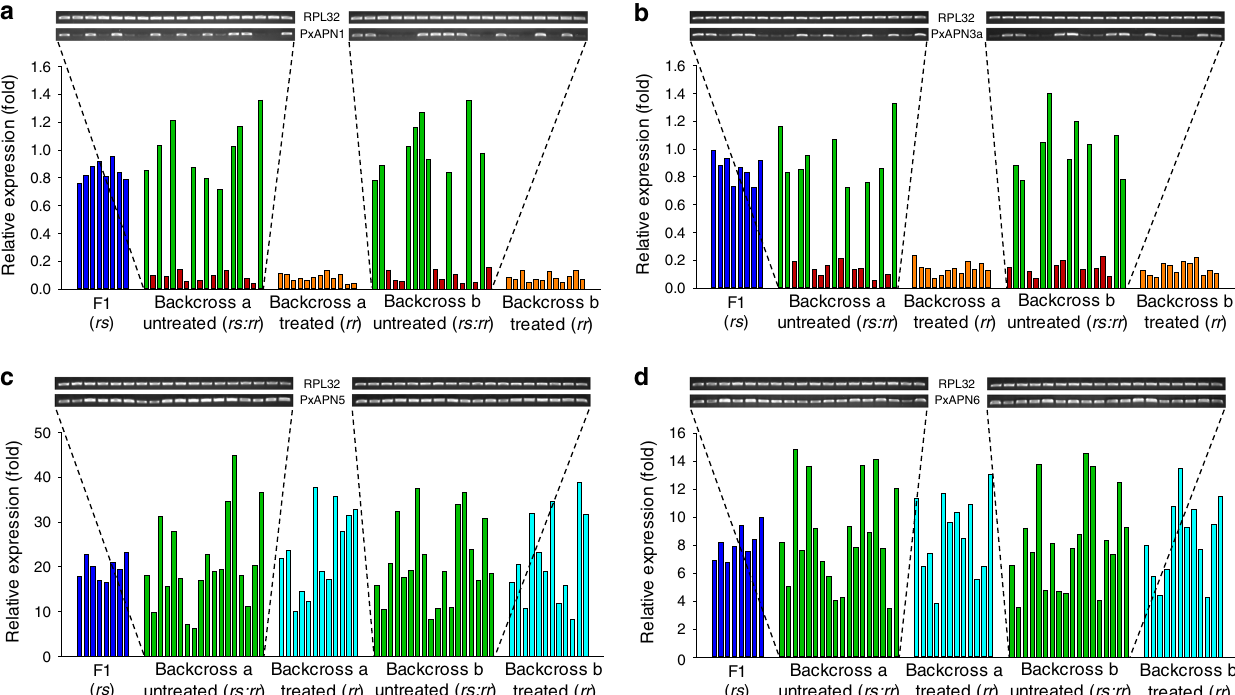
Fig. 3 Linkage of Cry1Ac resistance phenotype to reduced PxAPN1 and PxAPN3a expression. Expression levels for the F1, Cry1Ac-selected and non- selected backcross families are relative to levels in the susceptible DBM1Ac-S strain. Corresponding intensity of ampli fi ed transcript bands for the PxAPN1 ( a ), PxAPN3a ( b ), PxAPN5 ( c ), PxAPN6 ( d ) and the internal standard RPL32 gene are shown above each graph. Both results using larvae of the subfamily generated from backcrossing a female from F1 and a male from the NIL-R strain (backcross family a) and using larvae of the subfamily generated from backcrossing a male from F1 and a female from the NIL-R strain (backcross family b) are shown. Source data are provided as a Source Data fi